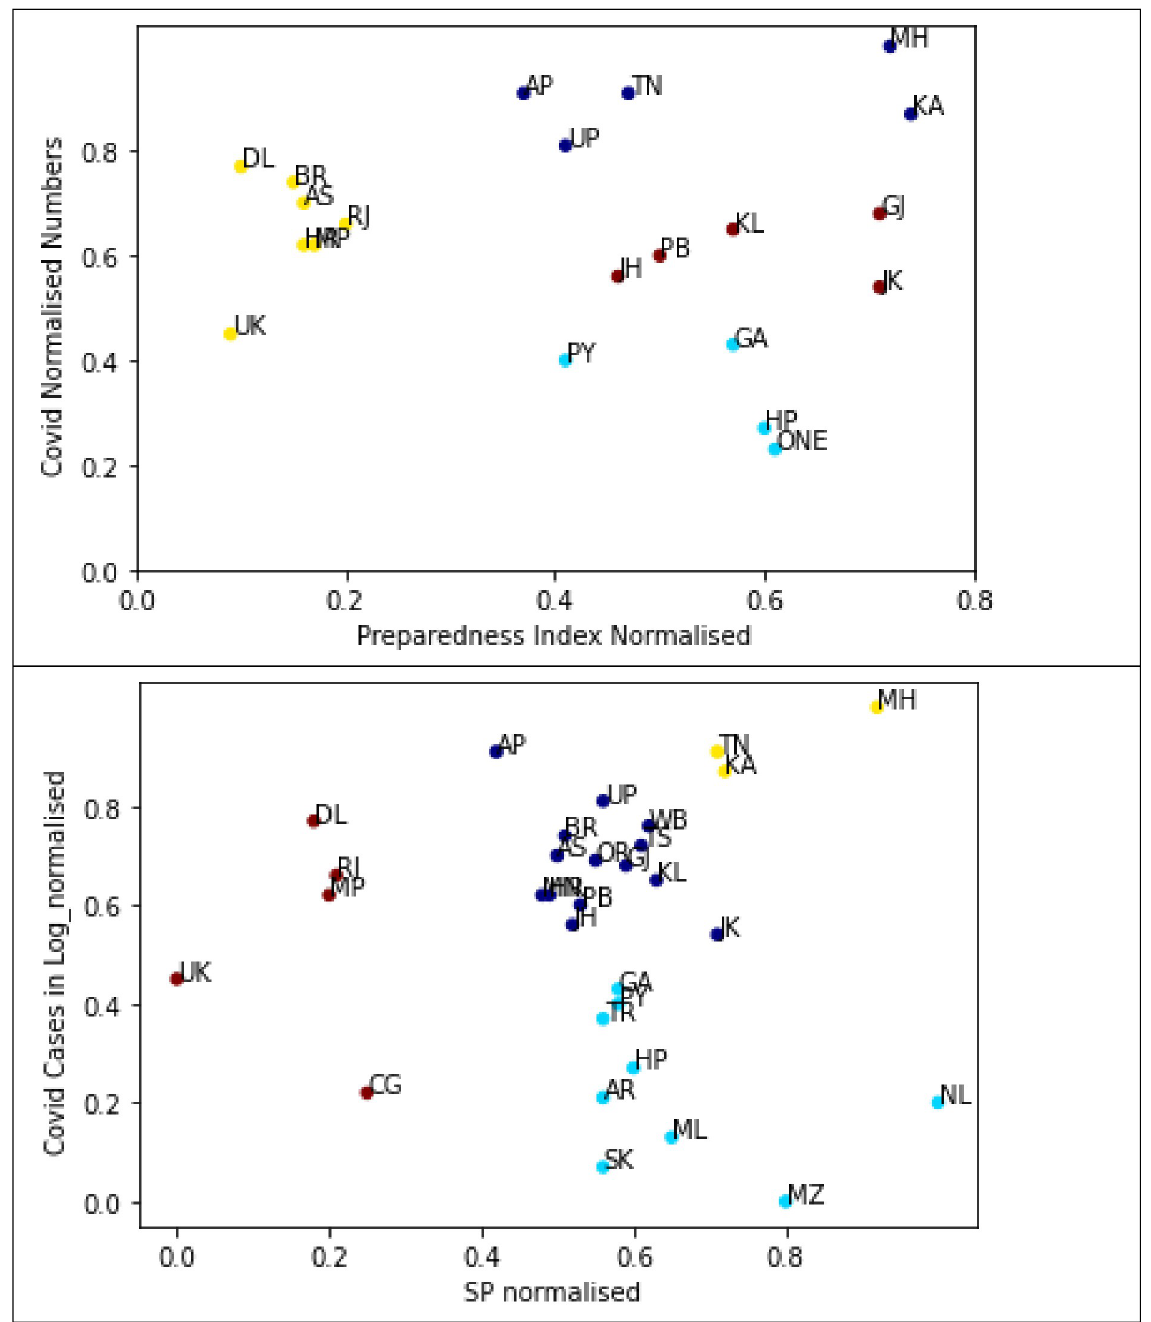
Fig 2. Clustering of states with different levels of preparedness when correlated with the number of active COVID cases in the state/ UT. (a) Overall HOSPI correlated with COVID cases; (b) Staff preparedness correlated with COVID